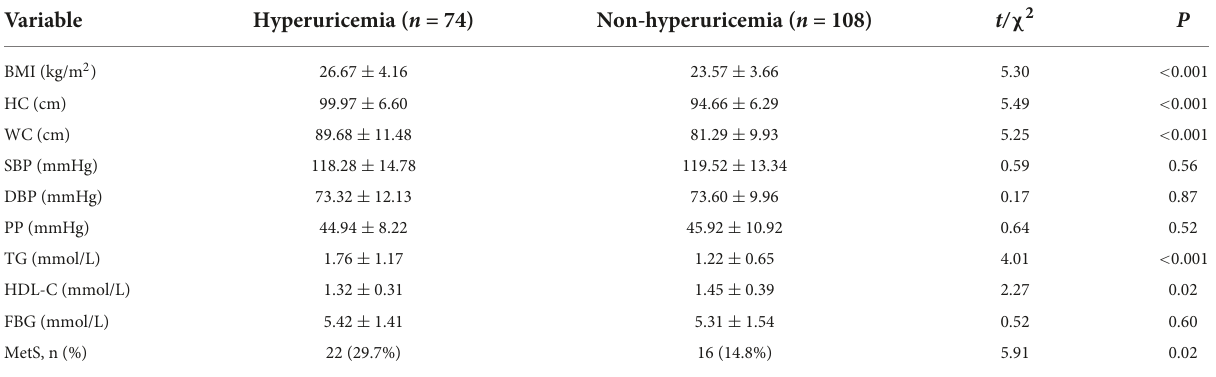
TABLE 4 Comparison of clinical characteristics in HUA with Non-HUA in patients with BPD.